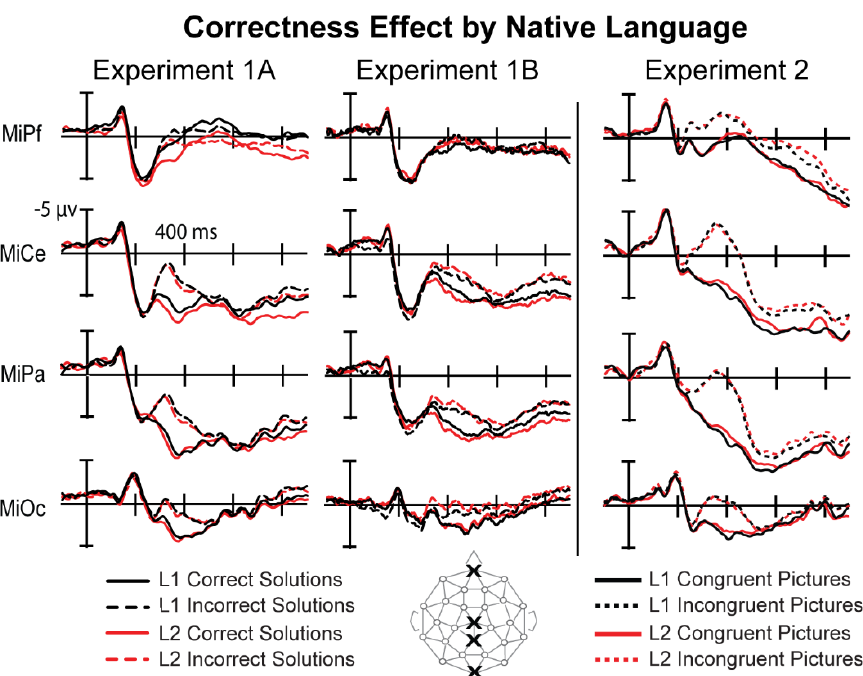
Figure 8. ERPs by native language. Grand average ERPs across midline electrodes time-locked to solution onset for Experiments 1A and 1B (left and center, respectively) and picture onset for Experiment 2 (right). Correct/congruent (solid lines) and incorrect/incongruent (dotted lines) items were preceded by spoken operands (Experiments 1A and 1B) or nouns (Experiment 2) in L1 (black) and L2 (red). It should be noted that L1 and L2 do not necessarily correspond to LA+ and LA − in all individuals. Robust P300 correctness effects are seen for both languages for Experiments 1A and 1B, whereas N400 congruency effects are seen for both languages for Experiment 2. Importantly, there were no differences in the size of the effect across languages for any task.